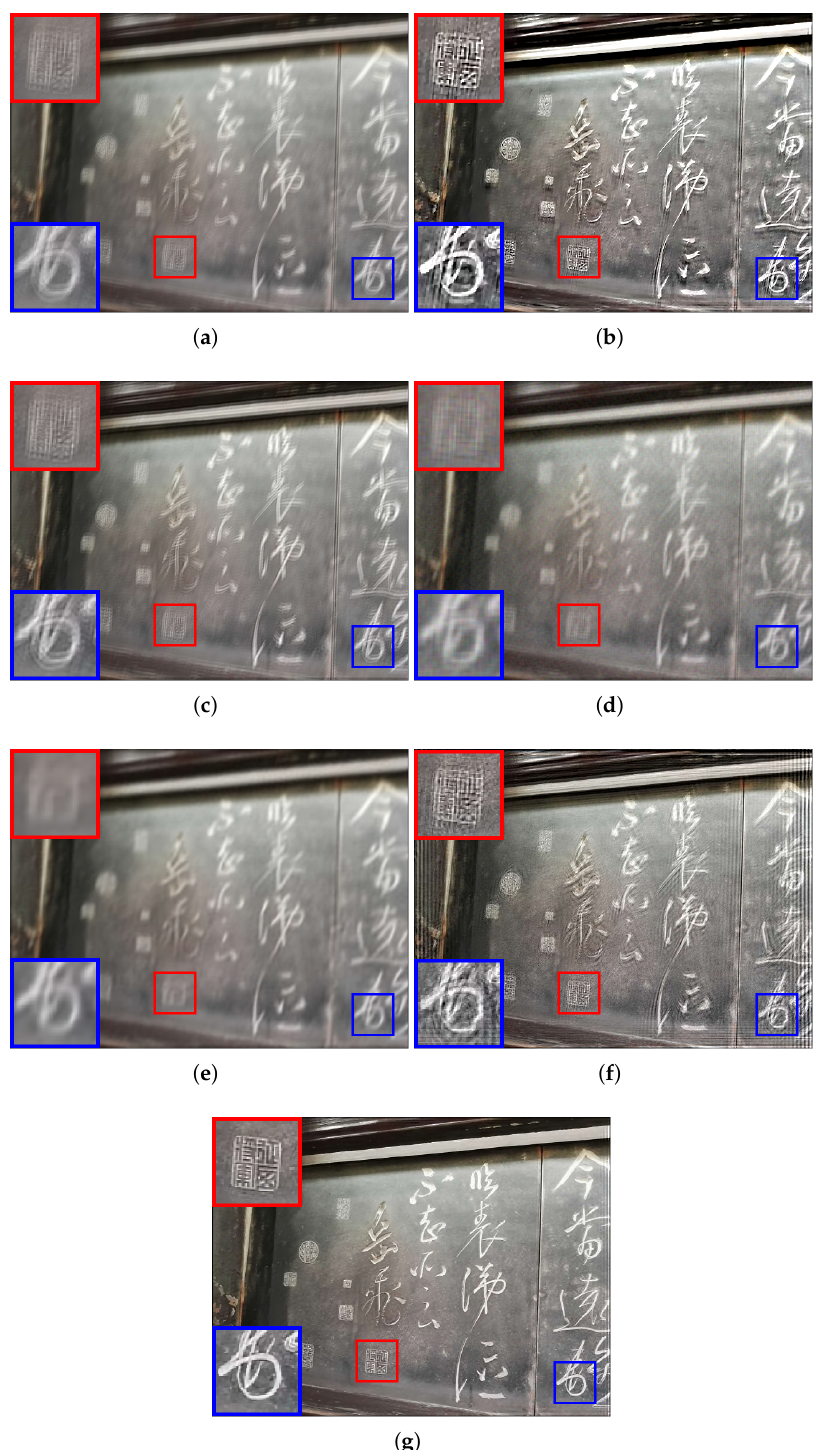
Figure 5. Comparison of different deblurring algorithms using a motion blur and continuous defocus blur image. ( a ) the input blur image; ( b ) the deblurring result of Xu’s method [33] (PSNR = 17.55, SSIM = 0.43); ( c ) the deblurring result of Shen’s method [34] (PSNR = 22.04, SSIM = 0.57); ( d ) the deblurring result of Yang’s method [35] (PSNR = 21.72, SSIM = 0.54); ( e ) the deblurring result of Dong’s method [26] (PSNR = 21.91, SSIM = 0.57); ( f ) the deblurring result of Wiener filter (PSNR = 21.16, SSIM = 0.51); ( g ) the deblurring result of proposed method (PSNR = 23.40, SSIM =